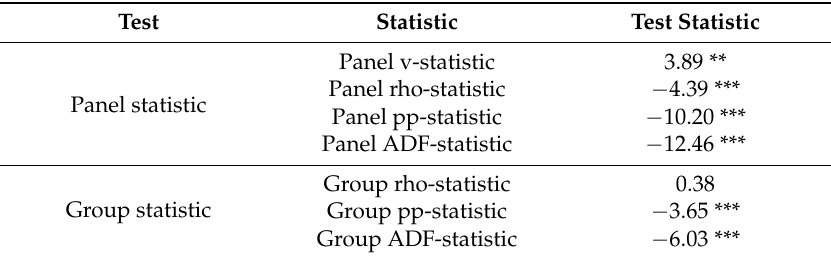
Table 4. Pedroni panel cointegration test results.